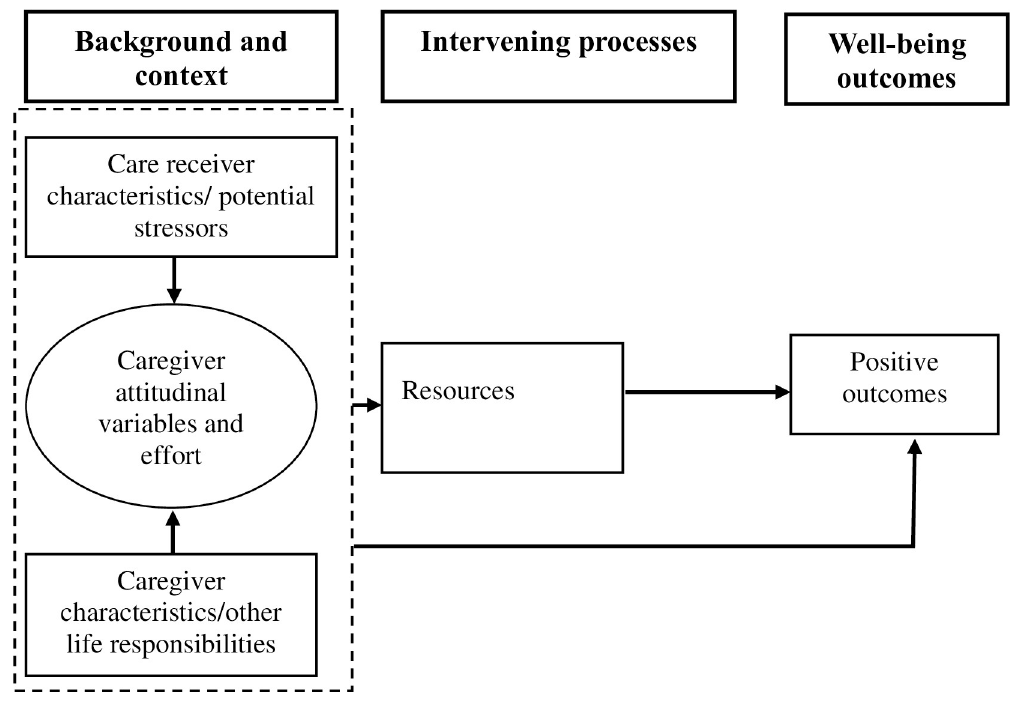
Fig 1. Conceptual framework for positive experiences of primary and secondary